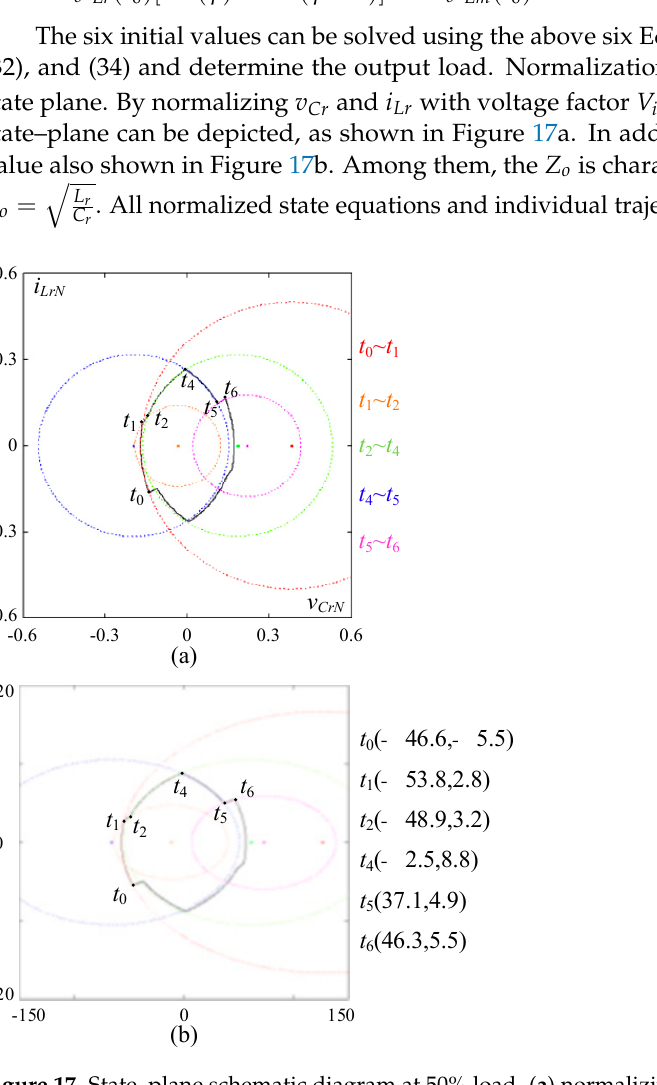
Figure 17. State–plane schematic diagram at 50% load. ( a ) normalizing form( b ) real value form. Table 3. Equations and state–plane trajectory.